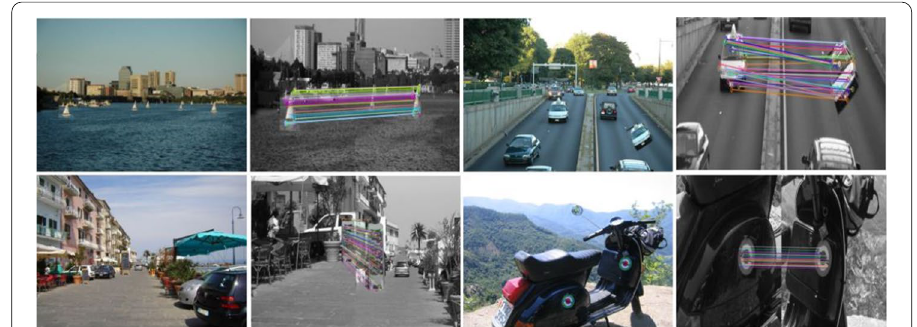
Fig. 14 The results of proposed method on FICC‑F220 and FICC‑F2000 dataset